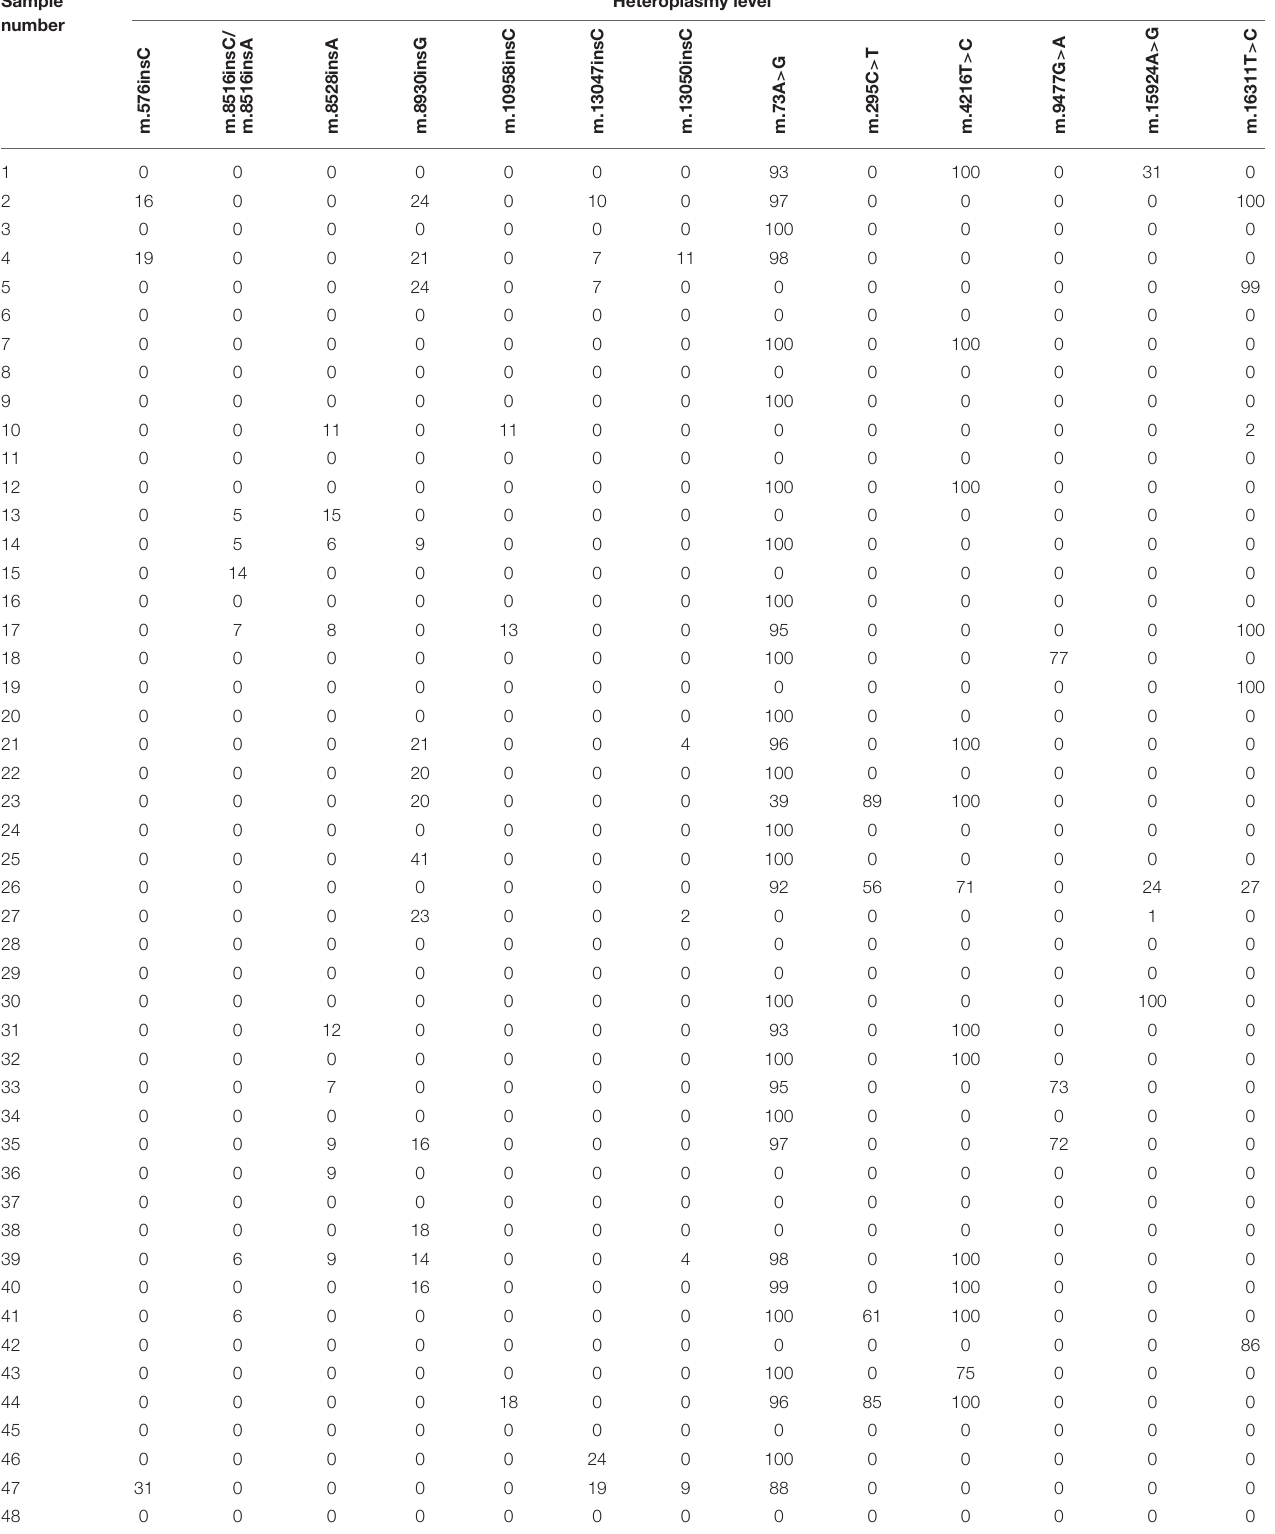
TABLE 2 | Common heteroplasmic mutations, identified in the study.